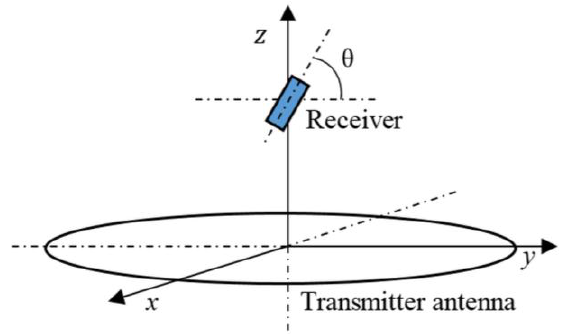
Figure 7. Angular misalignment θ between the TX and receiver (RX) antennas.